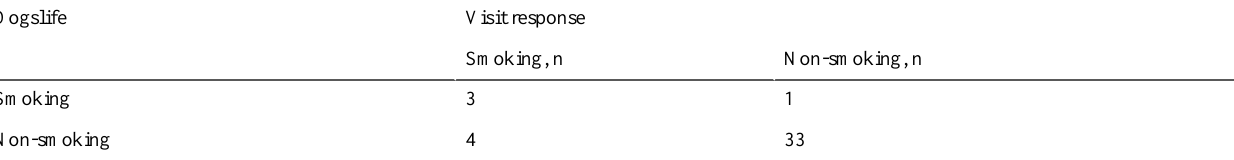
Table 4. Comparison of smoking in Dogslife record with visit response. Numbers entered refer to the count of